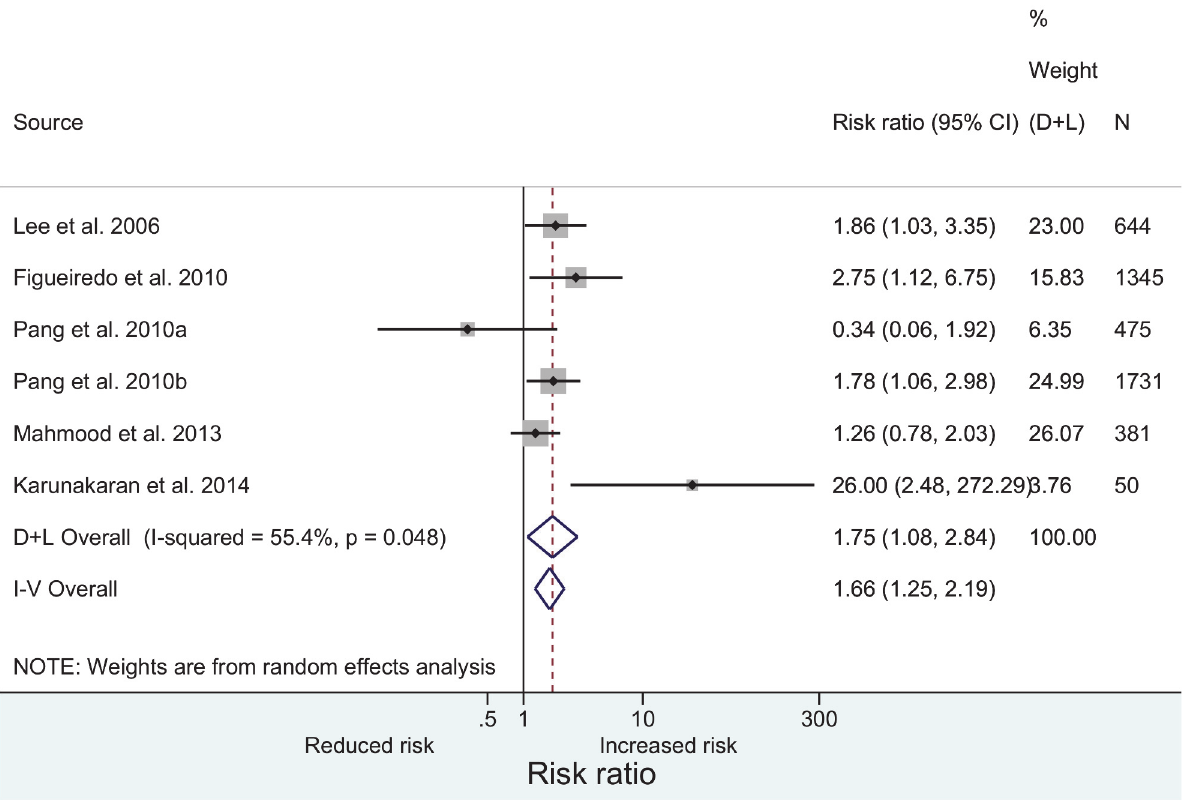
Fig 2. Meta-analysis of case-control studies on the association between diabetes mellitus and a severe clinical presentation of dengue.